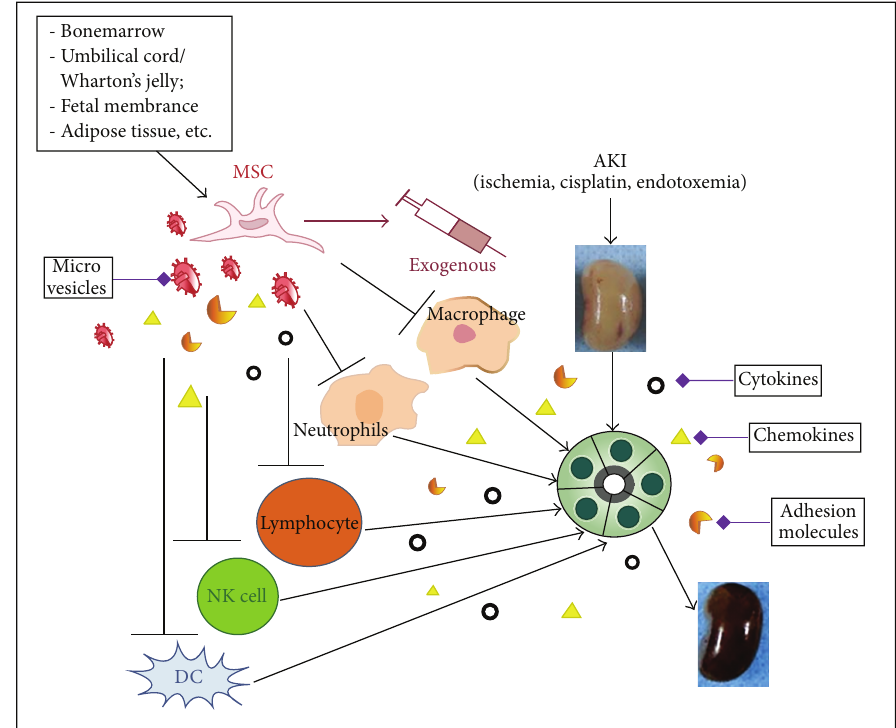
Figure 1: Exogenous MSCs likely involve paracrine effects in regulating the inflammatory mediators to ameliorate AKI. They exert protective and reparative effects in the treatment of AKI by regulating inflammatory mediators like cytokines, chemokines, neutrophils, lymphocytes, NK cells, DCs, and macrophages. MSCs ultimately improve the kidney’s structure and